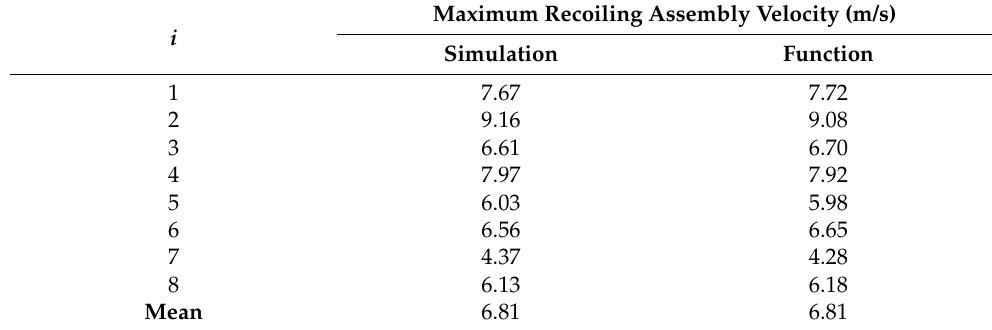
Table 6. The results of simulations compared to the results approximated by the obtained function— for the first